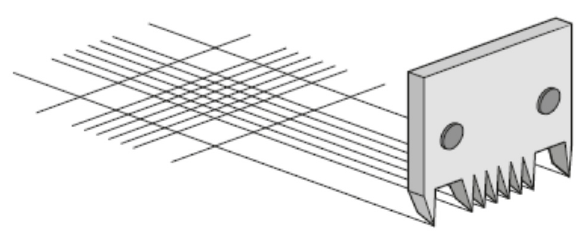
Figure 4. Cross-Cut tool illustration.